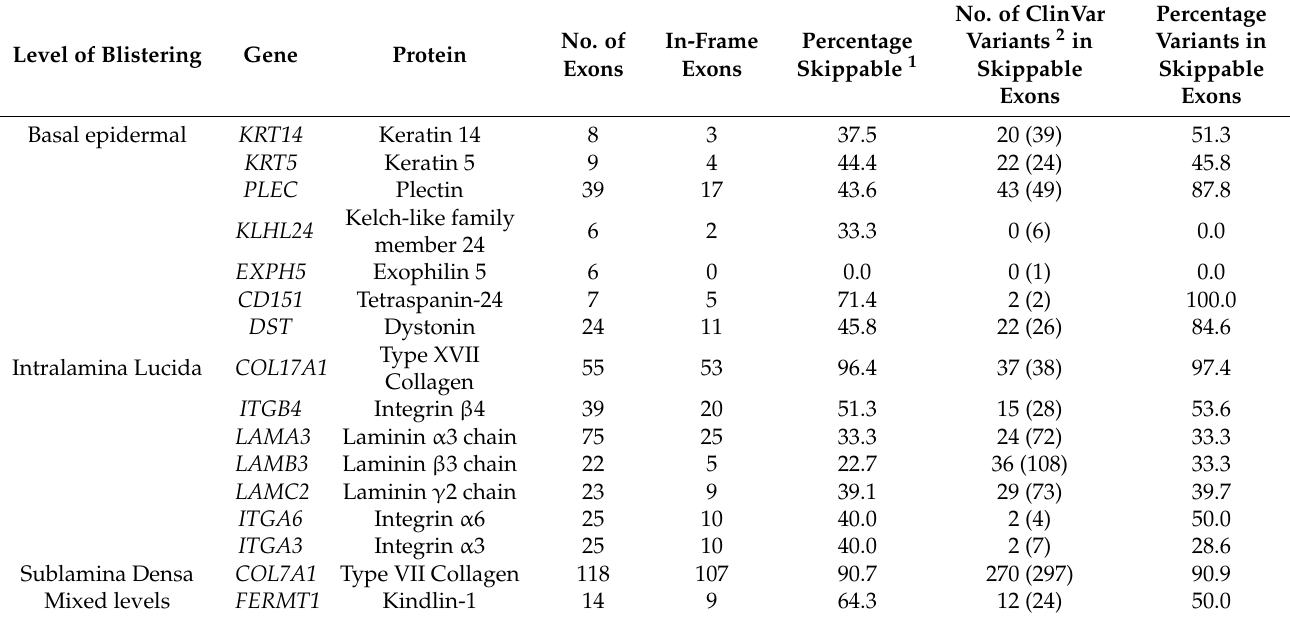
Table 1. Numbers of potentially skippable exons and pathogenic variants in those exons for each gene known to be involved in Epidermolysis